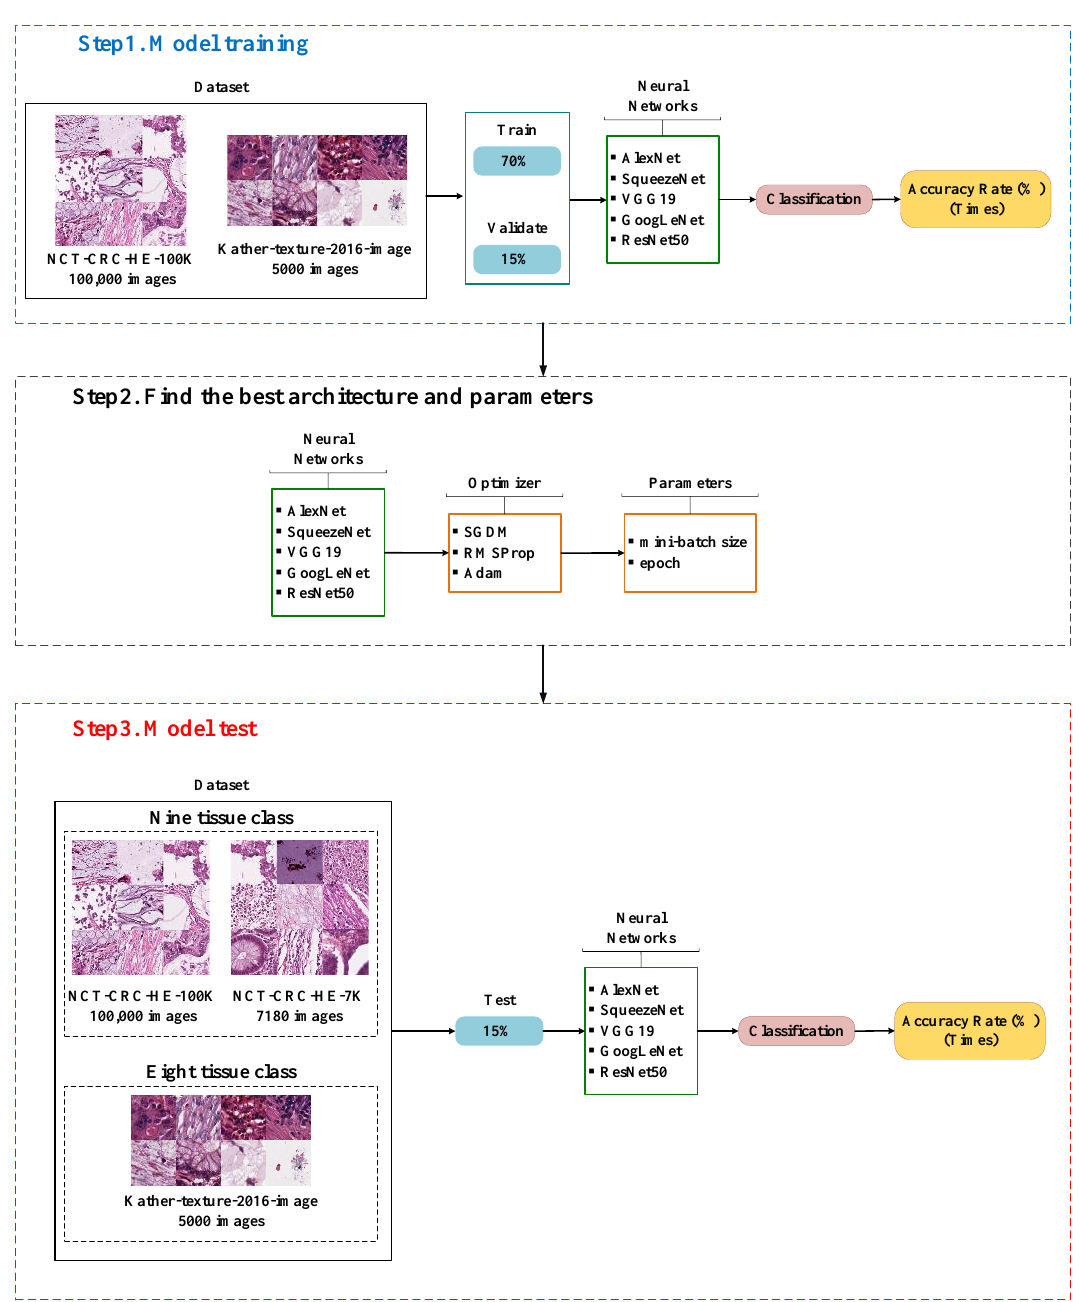
Figure 3. Deep learning structures to identify colorectal cancer tissue in this study.